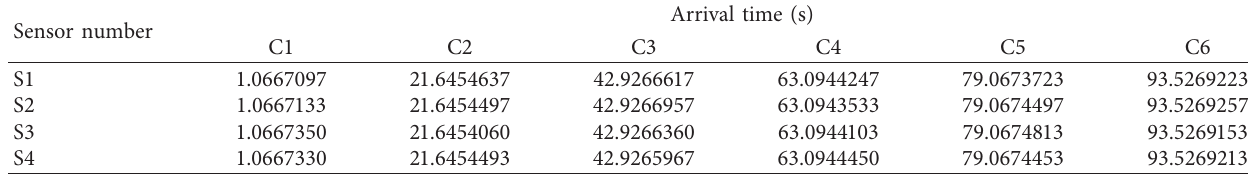
Table 10: First arrival time of the pulse sources for Scheme I of GAM-L.